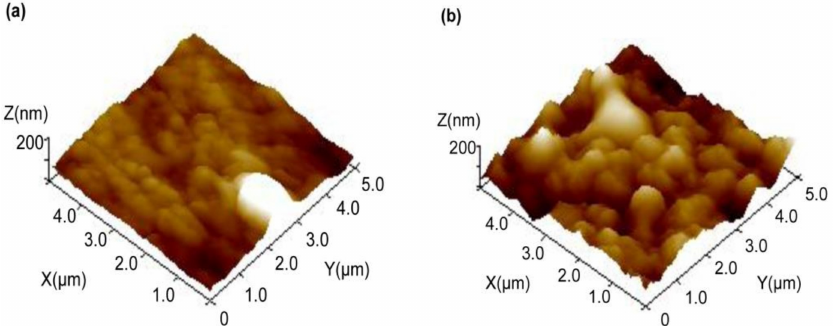
Figure 3. Physical topography of PE film untreated ( a ) and treated with D1 bacteria ( b ) by atomic force microscopy